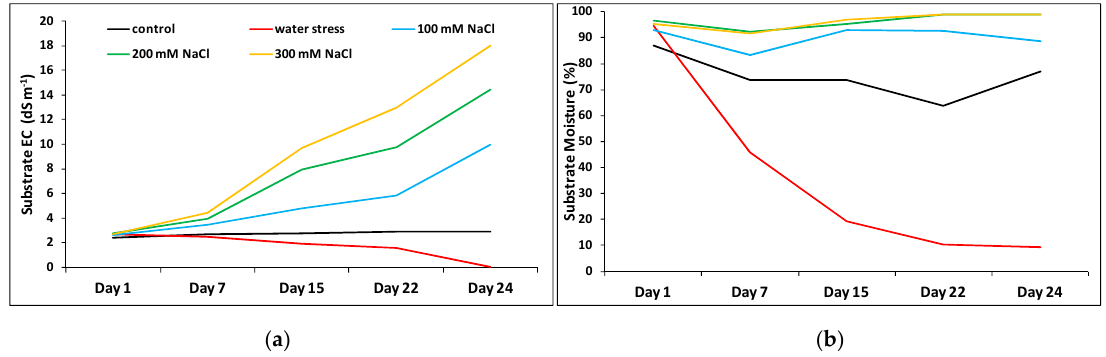
Figure 3. Substrate electric conductivity (dS m − 1 ) ( a ) and moisture (%) ( b ) in the pots of the control and stressed plants of Thalictrum maritimum grown in controlled conditions in the greenhouse.